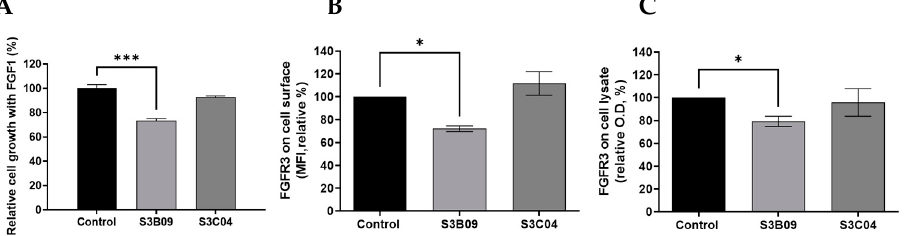
Figure 6. Biological functional assay of anti-FGFR3 antibodies. Inhibitory effect of clone S3B09 (Clade A) and S3C04 selected from conventional bio-panning on proliferation of FGFR3- overexpressing cells (PDC #1) was evaluated. Cells were cultured in the presence of 10 ng/mL FGF1 plus 10 μ g/mL heparin sulfate or with S3B09 or S3C04 antibodies. Relative cell growth was evaluated through ( A ) cell viability after 96 h incubation with antibodies. Data represent mean ± SD; ***, p < 0.001 using one-way ANOVA. ( B ) Cell surface FGFR3 degradation assay. Individual antibodies were treated on FGFR3-overexpressing cells (PDC #1) and incubated for 1 h at 37 °C, and FGFR3 expression on the cell surface was detected through FACS analysis. ( C ) Total FGFR3 degradation assay. After the FGFR3-overexpressing cells (PDC #1) were treated with the antibody, total FGFR3 contained in the cell lysate was detected through sandwich ELISA. Data represent mean ± SD; *, p < 0.03 using one-way ANOVA.